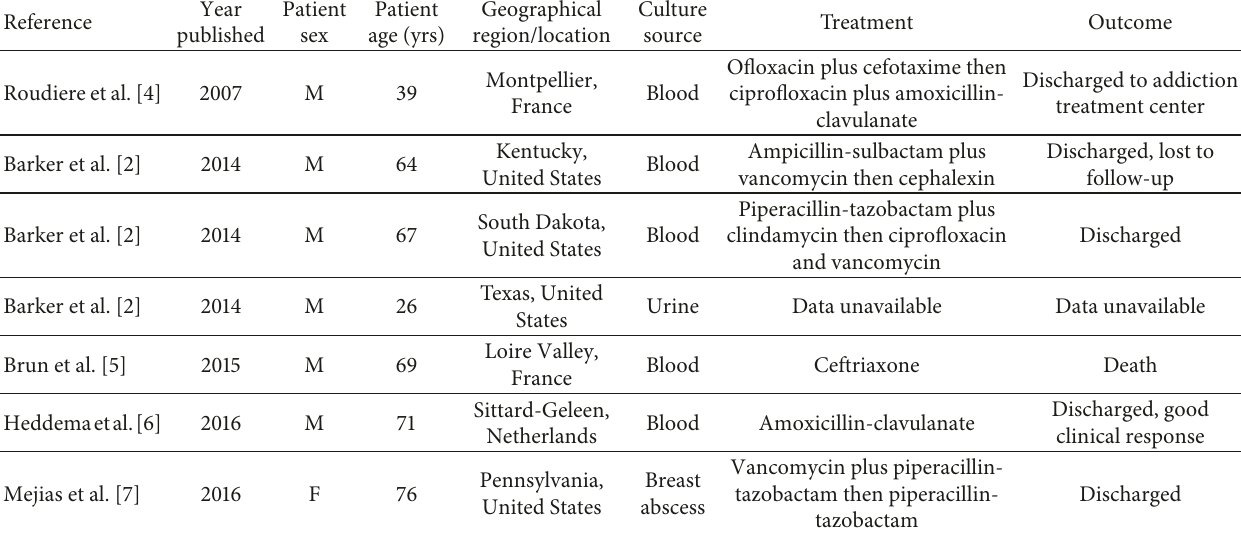
Table 2: Reported cases of Ignatzschineria indica as a human